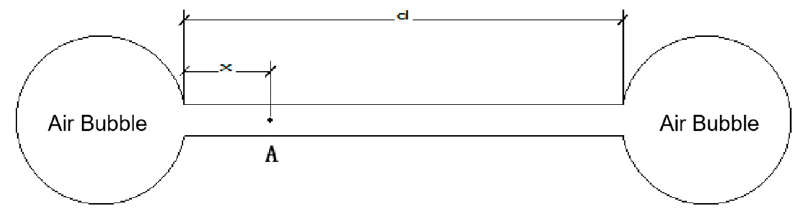
Figure 3. Hydrostatic pressure model.